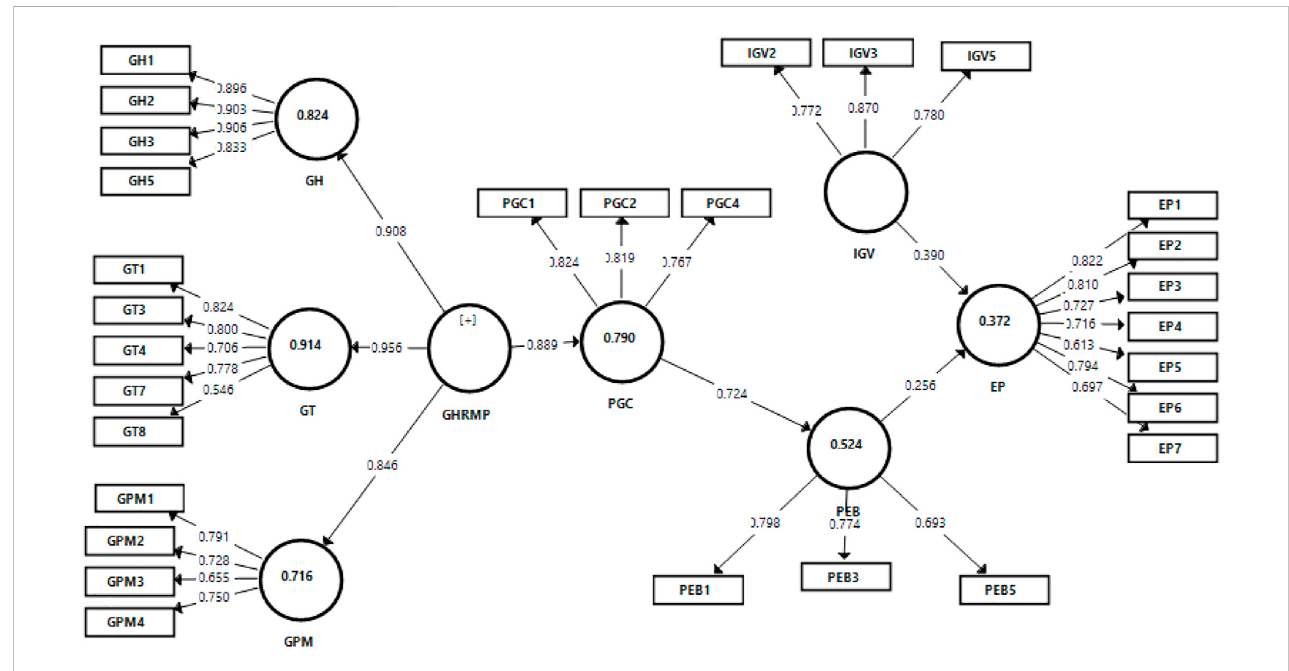
FIGURE 2 Measurement